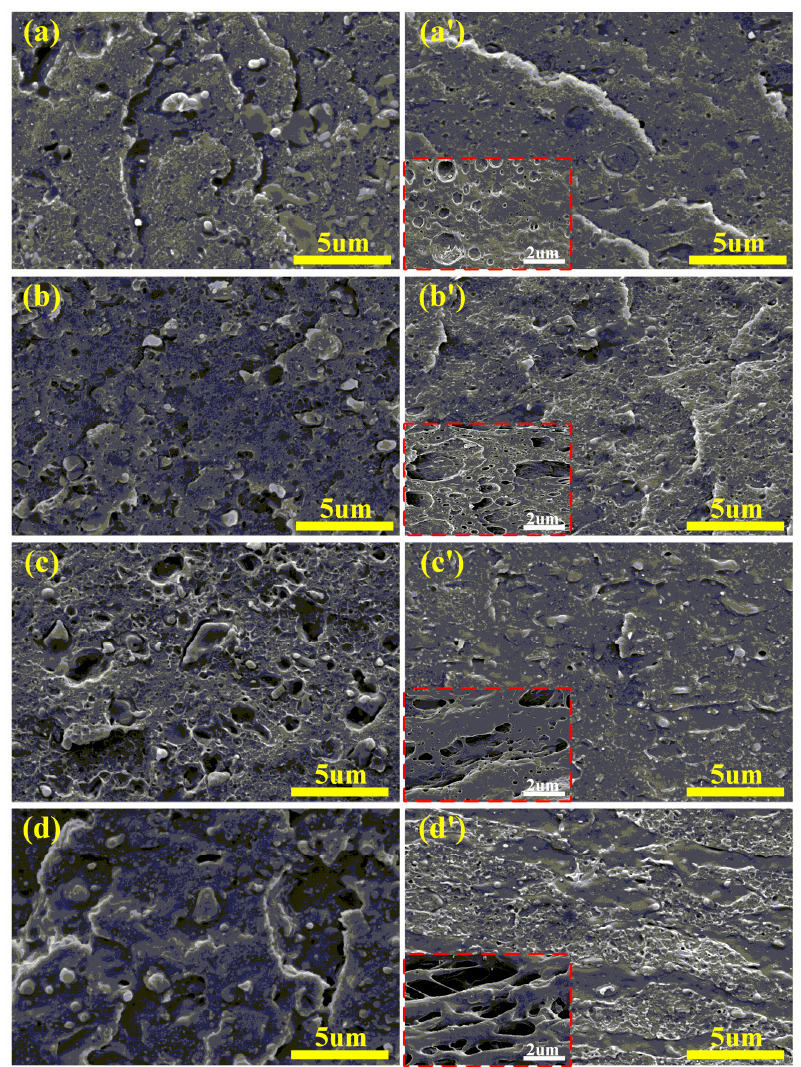
Figure 4. SEM micrographs of cryo-fracture of the rABS / SEBS blends and rABS / SEBS-g-MAH blends: ( a ) rABS / SEBS 95 / 5; ( a’ ) rABS / SEBS-g-MAH 95 / 5; ( b ) rABS / SEBS 90 / 10; ( b’ ) rABS / SEBS-g-MAH 90 / 10; ( c ) rABS / SEBS 85 / 15; ( c’ ) rABS / SEBS-g-MAH 85 / 15; ( d ) rABS / SEBS 80 / 20; and, ( d’ ) rABS / SEBS-g-MAH 80 /